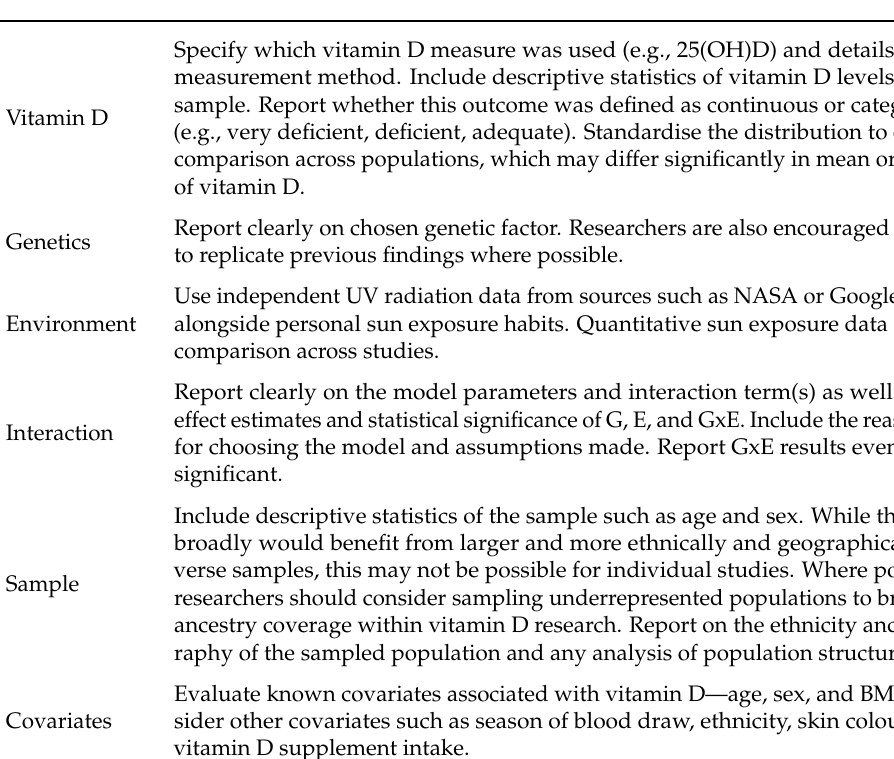
Table 3. Recommendations for GxE studies on Vitamin